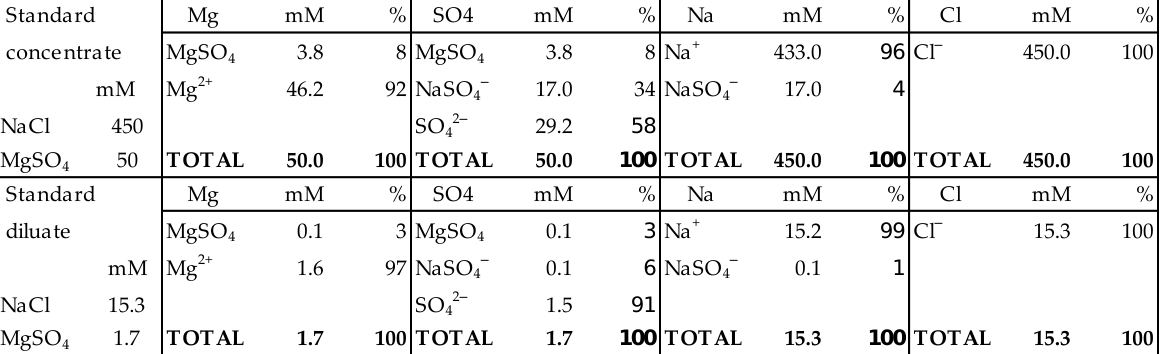
Figure 9. Ion pairs in standard concentrate and standard dilute according to OLI [47]. Only com- pounds are listed with more than 1% relative concentration.